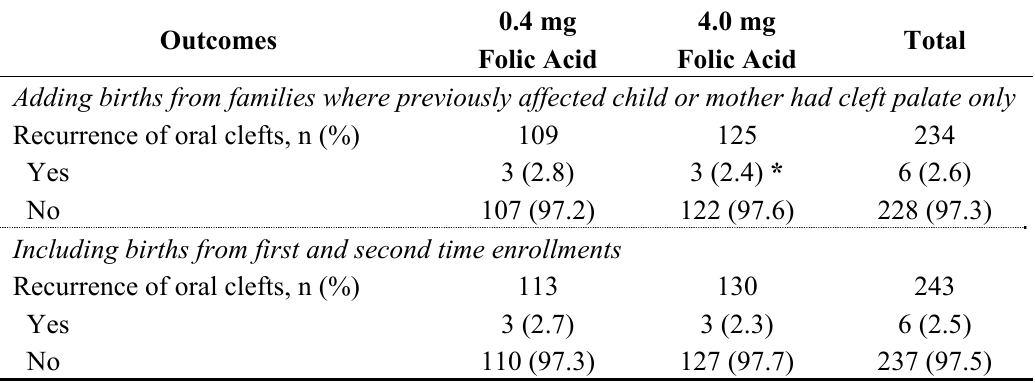
Table 1.1. Oral cleft recurrence outcomes for selected